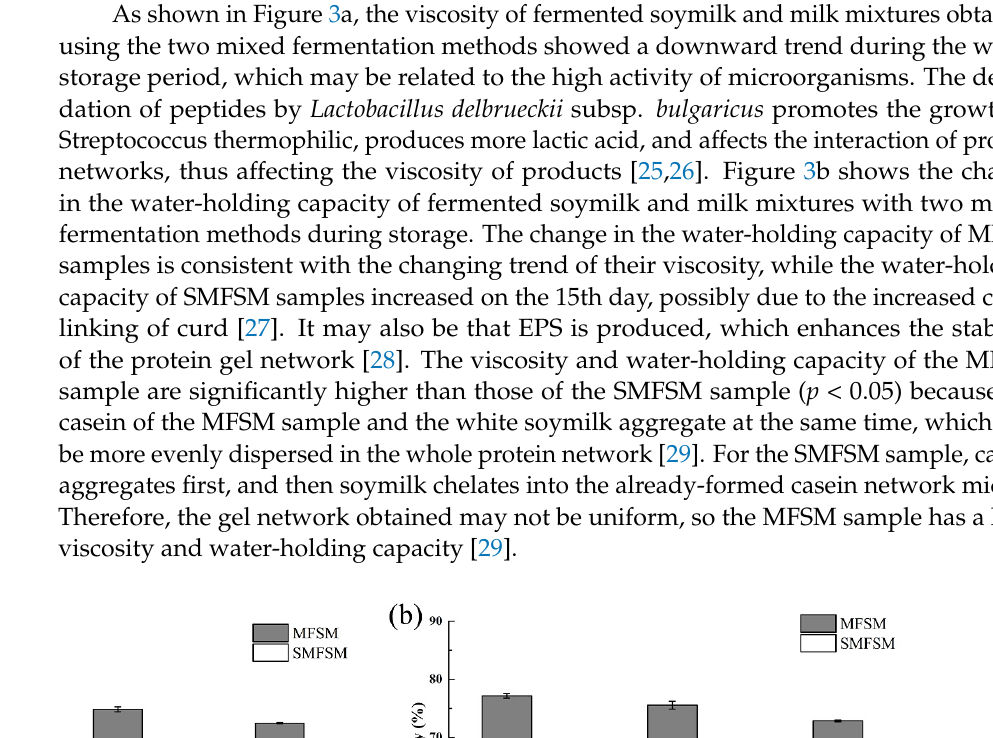
Figure 2. Effect of two mixed fermentation methods on the number of viable bacteria during storage: ( a ) the change in Streptococcus thermophilus during storage and ( b ) the change in Lactobacillus del- brueckii subsp . bulgaricus during storage .